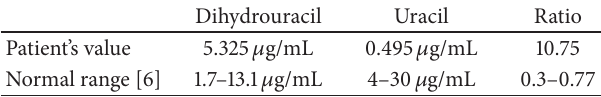
Table 2: Urinary analysis of dihydrouracil and